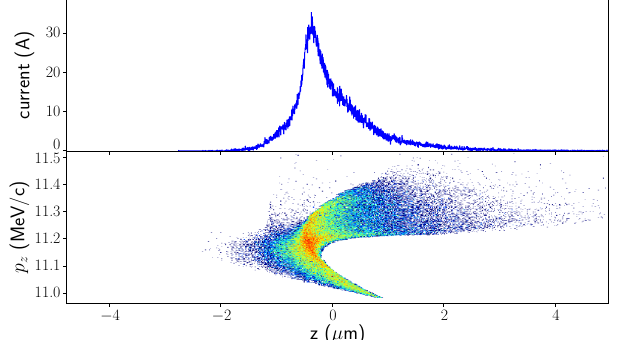
FIG. 6. The longitudinal phase space (LPS) and corresponding current profile is illustrated for the operational point yielding the largest beam brightness, B 6 D ¼ 1 . 3 × 10 22 , for ð ϕ ; E 0 Þ ¼ ð − 41 . 2 deg ; 123 . 75 MV = m Þ . The maximum peak current of the bunch is ∼ 35